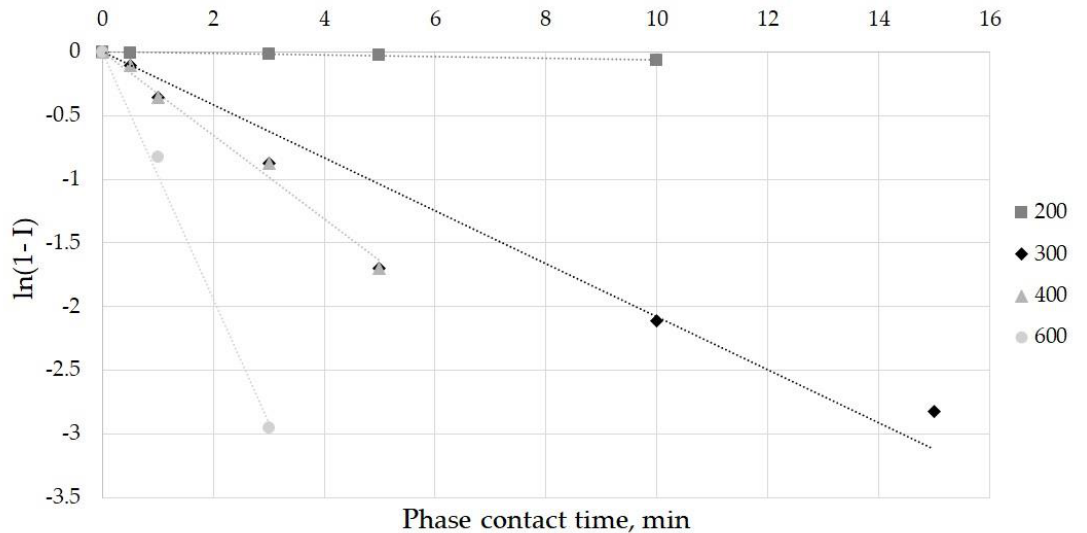
Figure 7. The logarithmic dependences of the degree of approaching to iron (III) extraction equilibrium on the stirring rate at a temperature of 300 K.